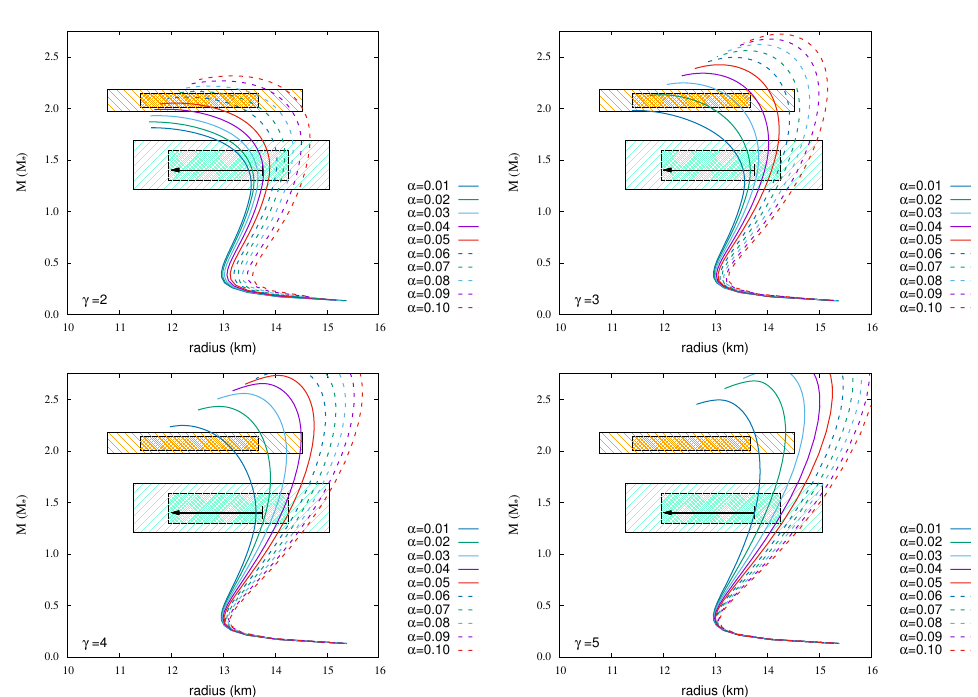
Figure 4. MR relations of GM1 EoS with magnetic fields. The strength of surface magnetic field strength B s is 10 12 G, and the central magnetic field strength B 0 is 2.5 × 10 18 G. The arrow and colored hatched areas are the same as in Figure